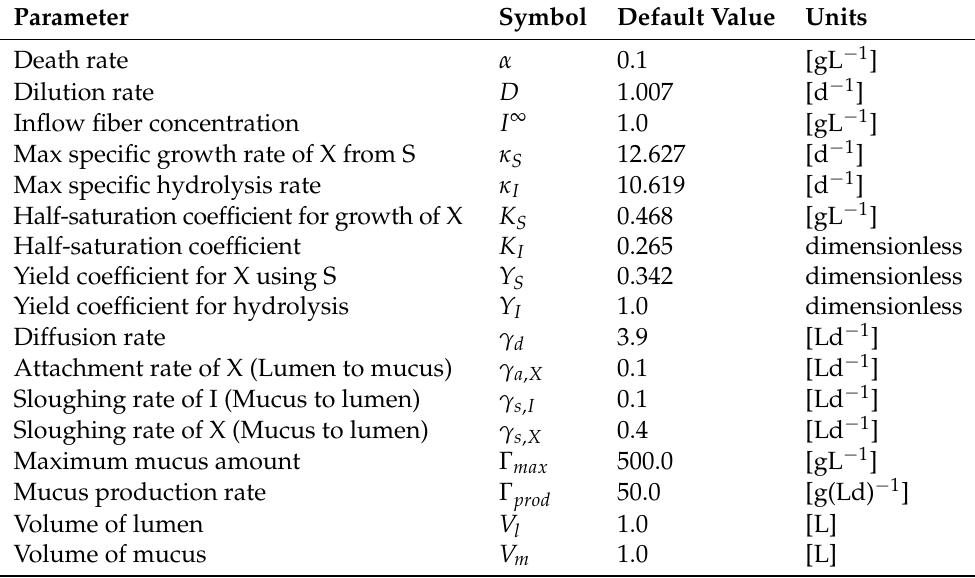
Table 2. Default parameters used in numerical simulations for dual compartment model, adapted from [17].